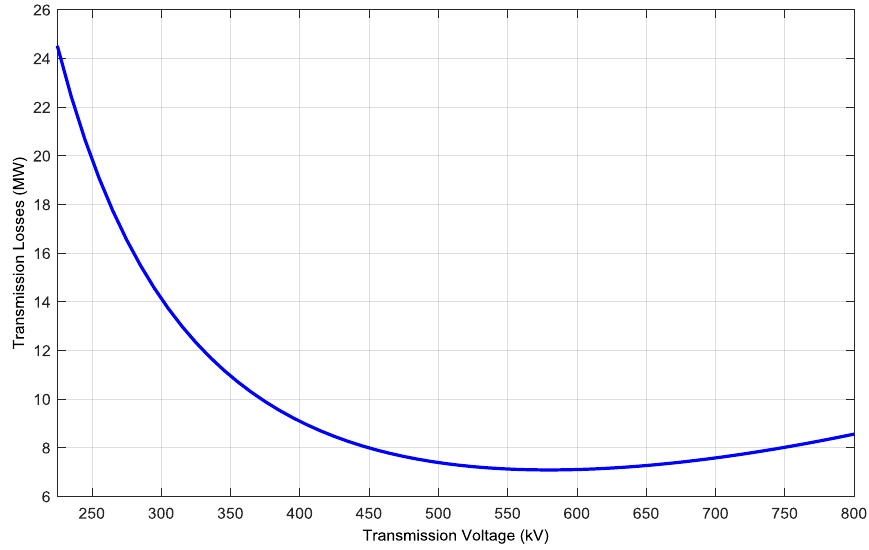
Figure 4. Total losses of the system as a function of the transmission rated voltage.